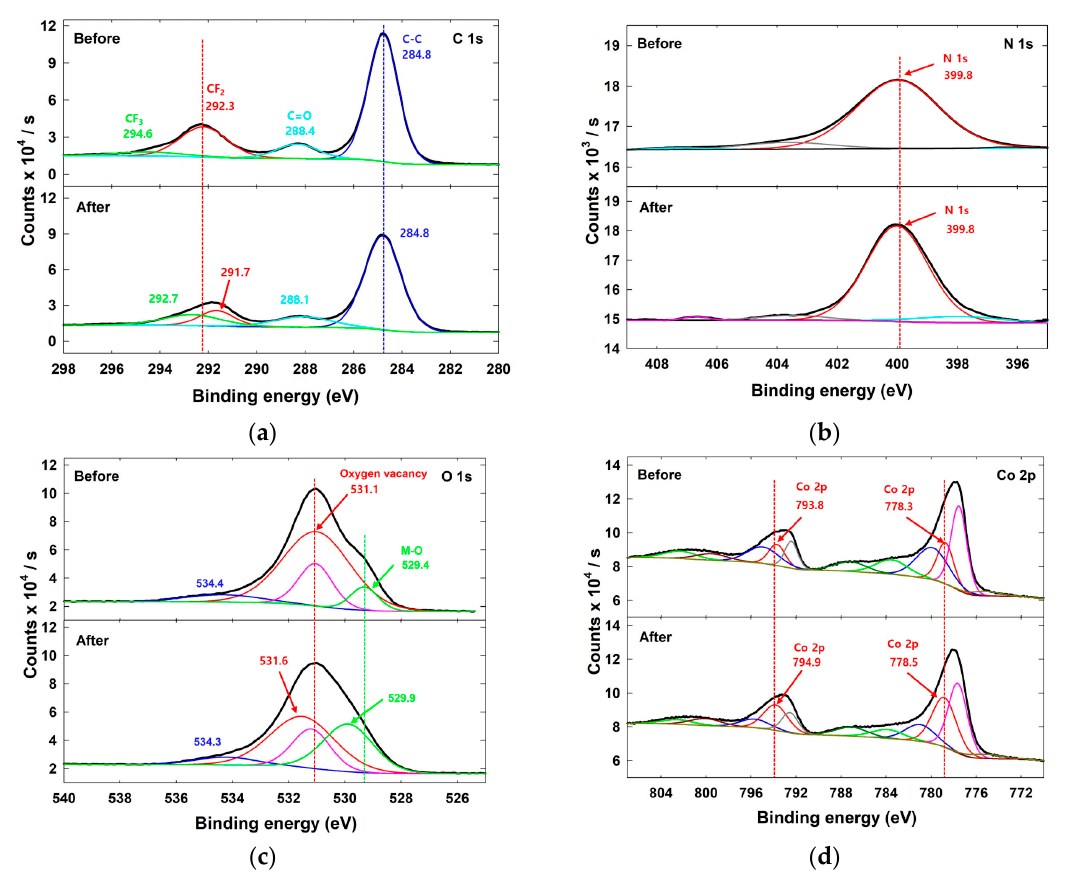
Figure 4. XPS spectra for ( a ) C 1s, ( b ) N 1s, ( c ) O 1s, and ( d ) Co 2p regions using a catalyst 1 /rGO composite-modified indium tin oxide (ITO) electrode before and after electrochemical measurements. The colored lines show the result of deconvolution.